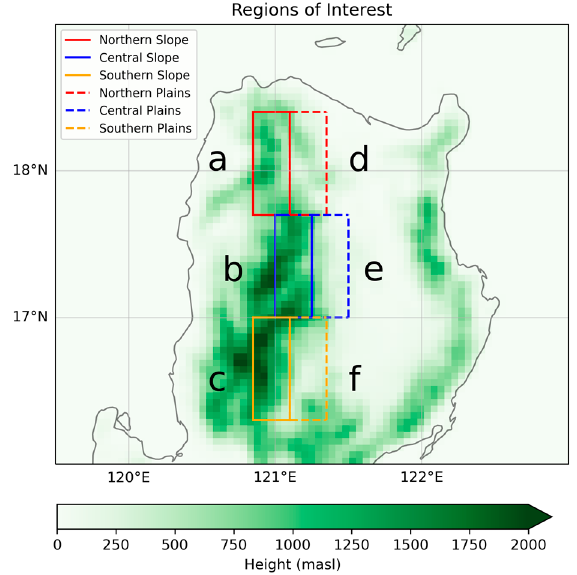
Figure 11. The Northern (red), Central (blue), and Southern (yellow) regions towards the east of the CMR. The solid boxes (a, b, and c) enclose the eastern slope of the mountain, while the dashed boxes (d, e, and f) show the plains regions towards the east of the mountains.